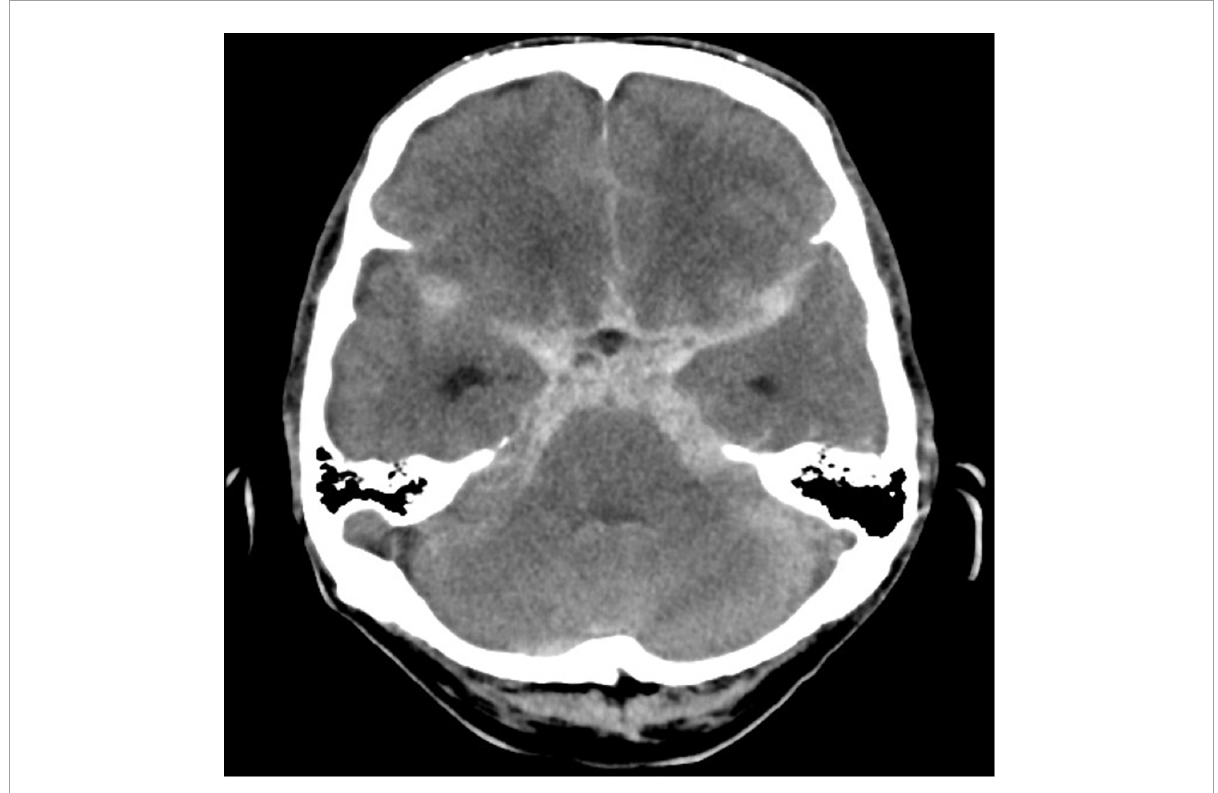
FIGURE1 Computed tomography brain showing extensive acute subarachnoid